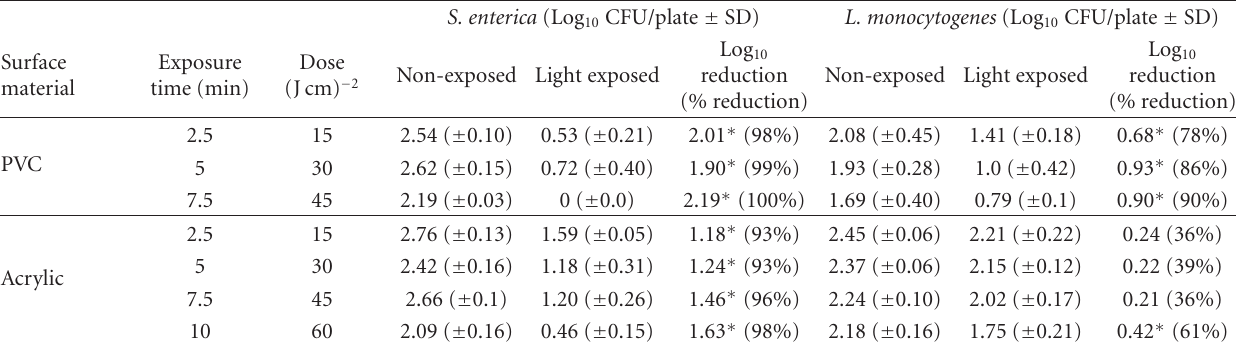
Table 3: Inactivation of bacteria aerosolised onto PVC and acrylic surfaces upon exposure to 110 mWcm − 2 of high-intensity 405 nm